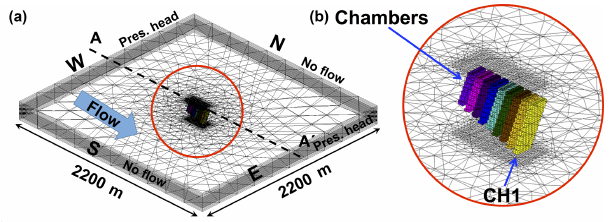
Figure 1. General view of the numerical model (a) and detailed view of the modelled chambers (b)